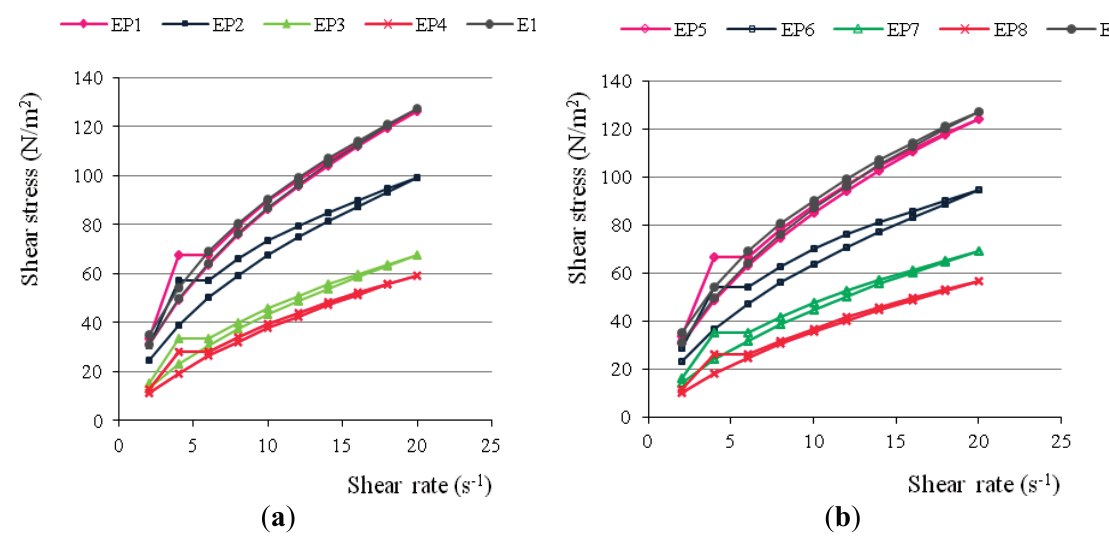
Figure 1. Rheograms of hydrogels with different concentrations of ( a ) PAMAM-NH 2 G2 and ( b ) PAMAM-NH 2